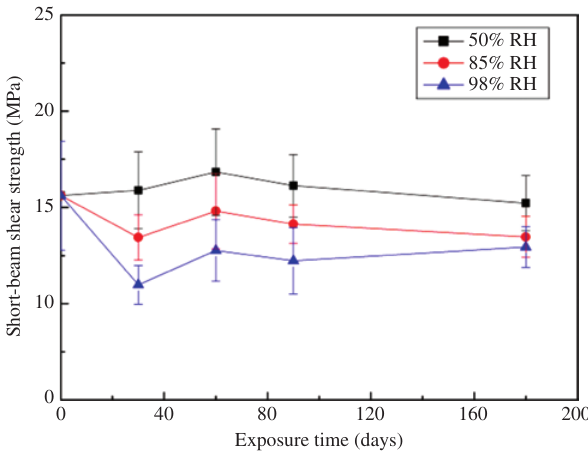
Figure 8 Variation of the short-beam shear strength as a function of exposure time of ramie fiber fabric reinforced phenolic resin samples at room